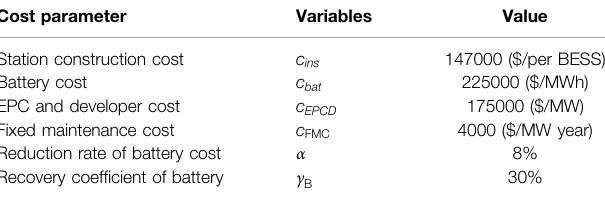
TABLE 1 | Main cost parameters of the